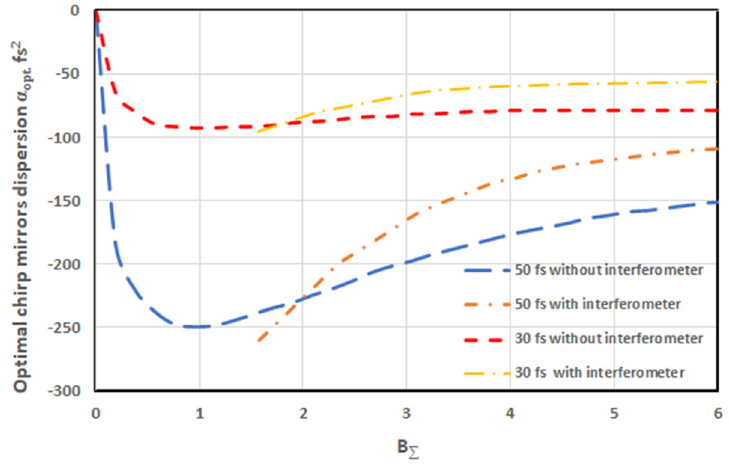
Figure 3. B Σ -dependence of parameter α opt for different pulse durations with and without inter- ferometer.